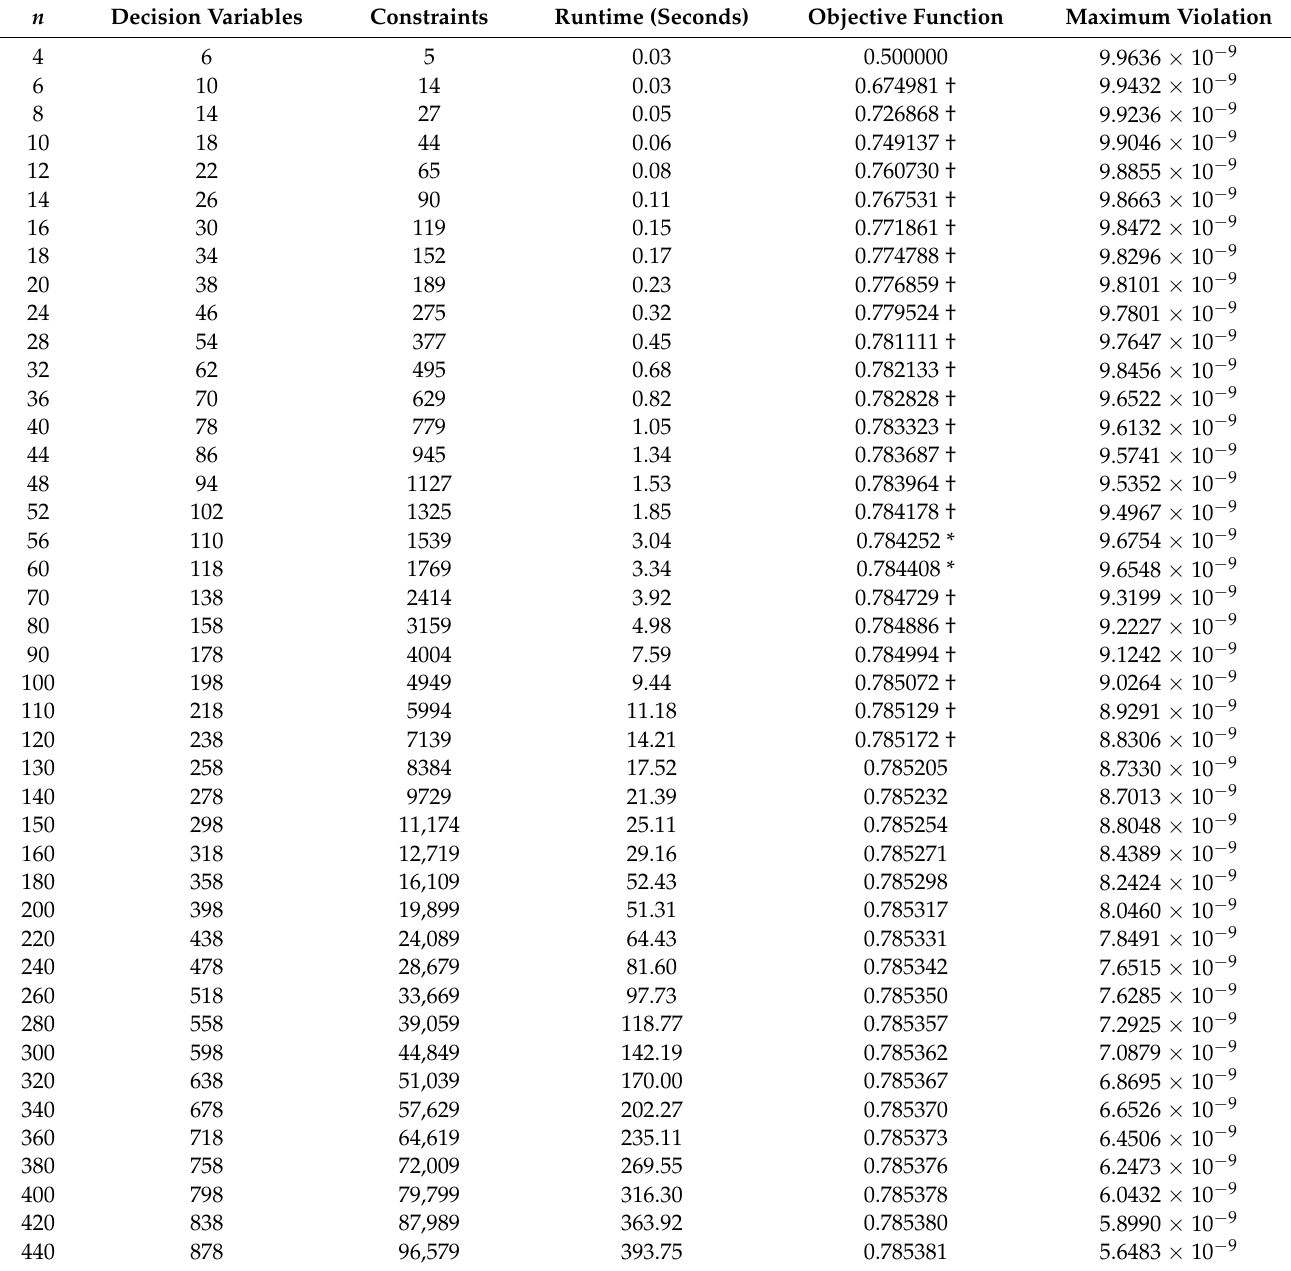
Table 1. Mathematica -IPOPT numerical results for a selection of even values of n